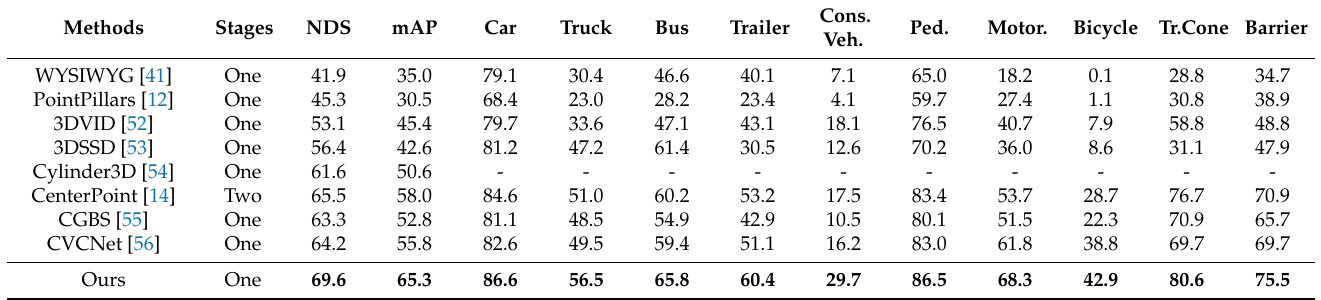
Table 6. Comparison with state-of-the-art methods on the nuScenes test set. The table is mainly sorted by nuScenes detection score (NDS).